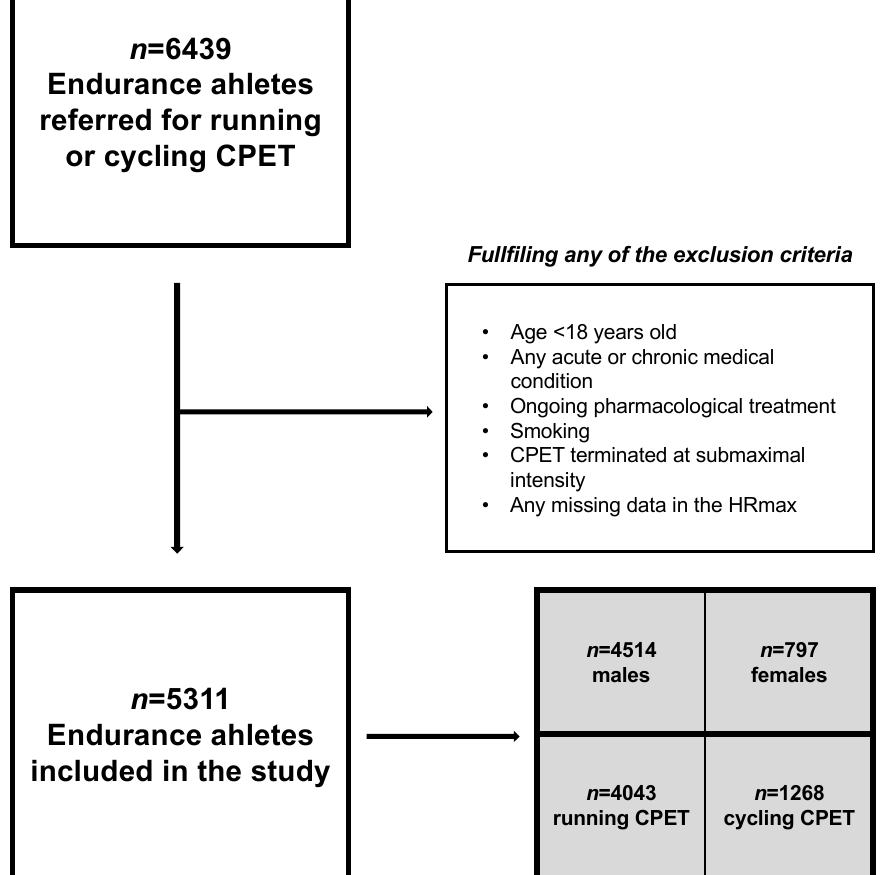
Figure 1. Flow diagram for inclusion procedure. Abbreviations: CPET, cardiopulmonary exercise test; HRmax, maximal heart rate. From 6439 endurance athletes screened for inclusion in the years 2013–2021, 5311 (82.48%) met the study criteria.